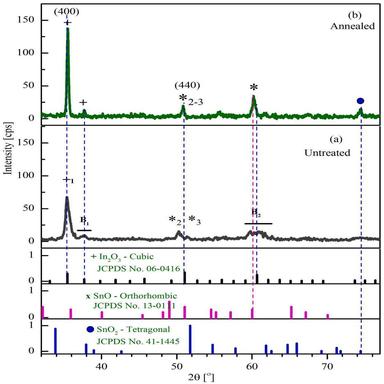
XRD patterns of ITO films: (a) untreated and (b) annealed films.